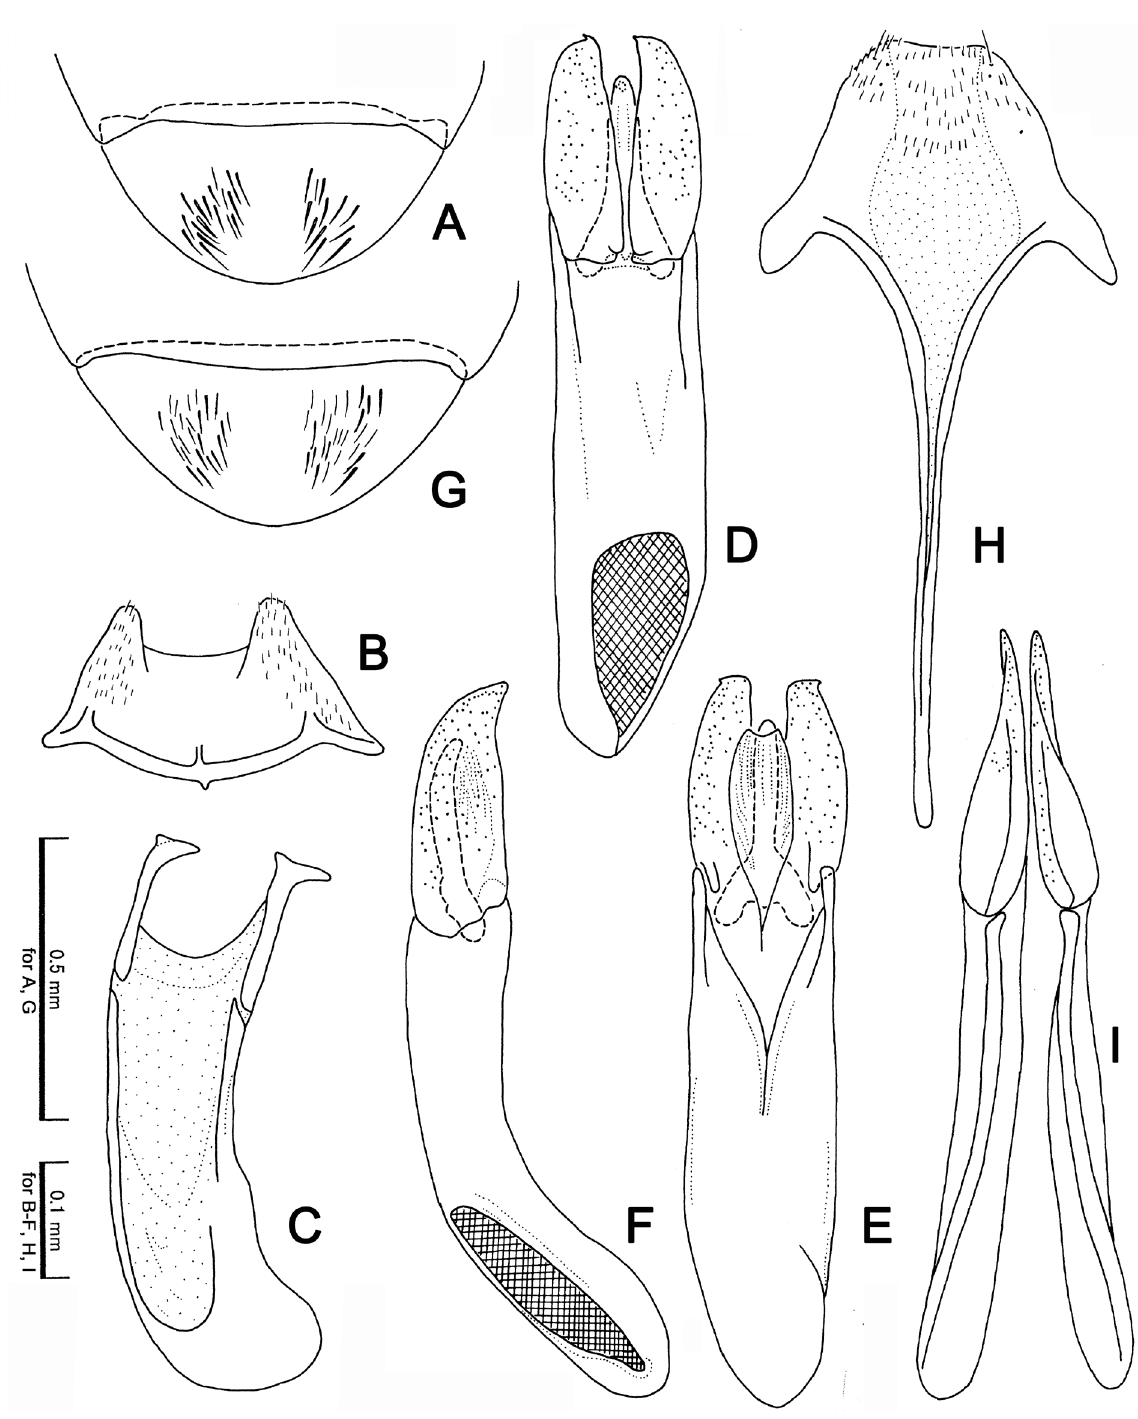
Fig. 7. Acontosceles siwalikensis Pütz, 2008, male (A–F) and female (G–I) genitalia (NME). A, G . Sternite VII. B . Sternite VIII. C . Sternite IX. D . Aedeagus, dorsal view. E . Aedeagus, ventral view. F . Aedeagus, left lateral view. H . Urosternite. I .